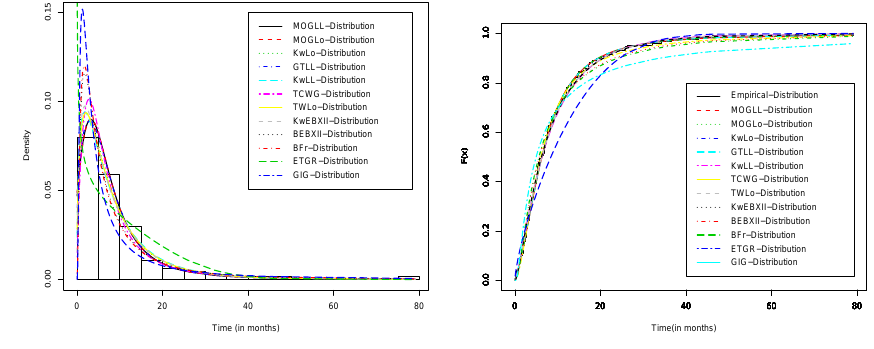
Figure 5 – Fitted pdfs (left panel) and cdfs (right panel) for cancer data.